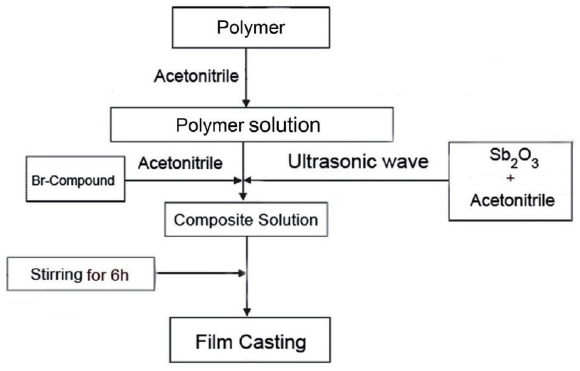
Figure 3. Schematice diagram of preparation nanocompos- ite.